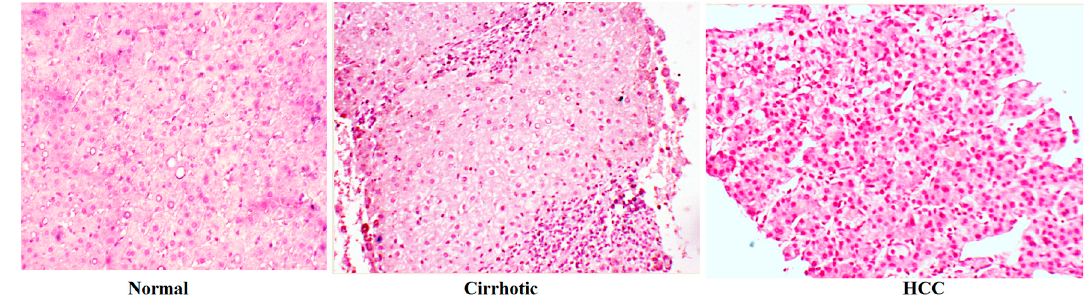
Figure 1. Histological aspects of normal liver, cirrhotic liver and hepatocellular carcinoma (HCC). Magnification, 100×.